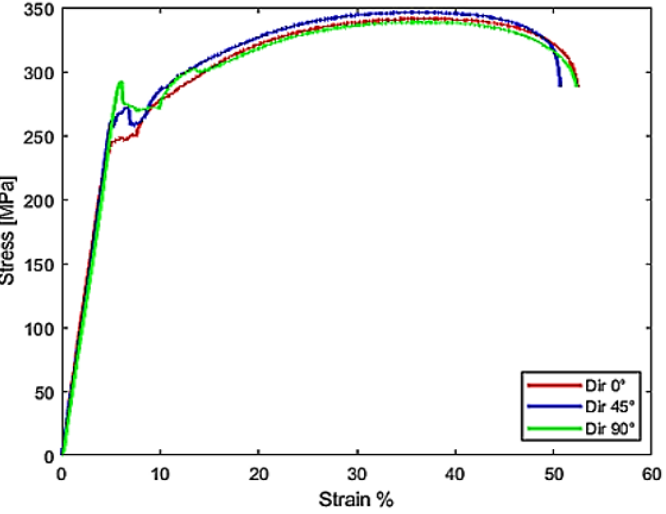
Figure 2. Conventional curves of specimens with respect to the rolling direction 0, 45, and 90°.